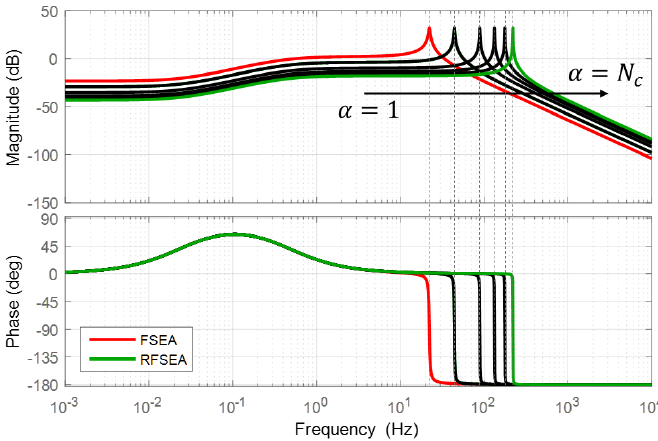
Figure 22. Frequency responses of open-loop dynamics for SEA force